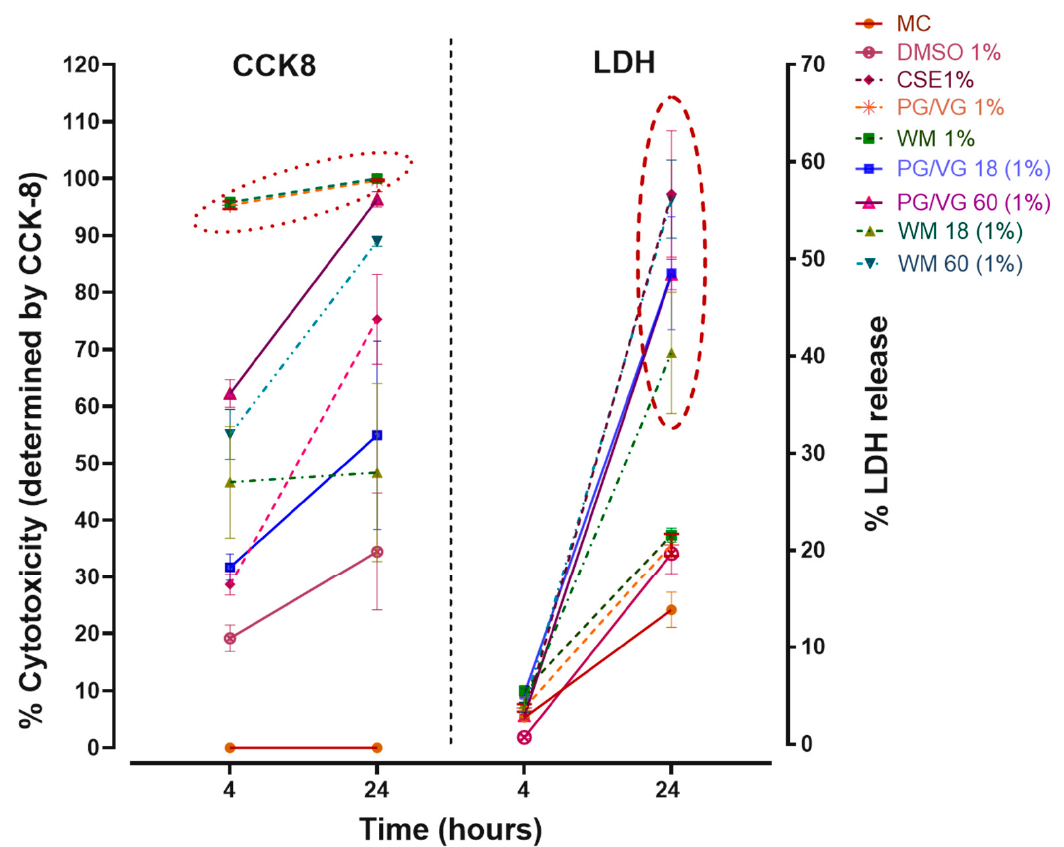
Figure 6. Time- and nicotine-dependent changes in LDH release and cytotoxicity of BEAS-2B cells following electronic cigarette aerosol and cigarette smoke exposure: Graphical representation comparing percent cytotoxicity ( left ) and percent lactate dehydrogenase (LDH) release ( right ) in BEAS-2B cells for 4 and 24 h post-treatment with condensates (1%) with and without nicotine, and cigarette smoke extract (CSE1%) and DMSO1%, with non-treated cells as controls (MC). Overall percentage increase in cytotoxicity was noticed in all treatments over controls. A nicotine-associated differential effect was accentuated in CCK-8 results for most nicotine-containing condensates (PG/VG 18 mg, PG/VG 60 mg, WM 60 mg, CSE) but is absent for PG/VG 1% and WM 1% (marked in a dotted circle). Watermelon-flavored e-liquid and PG/VG nicotine-containing condensates (marked in the red dashed circle) showed a higher percent LDH release similar to CSE treatment, while watermelon (WM) and PG/VG on their own showed lower LDH release. n = 3–4 independent experiments.